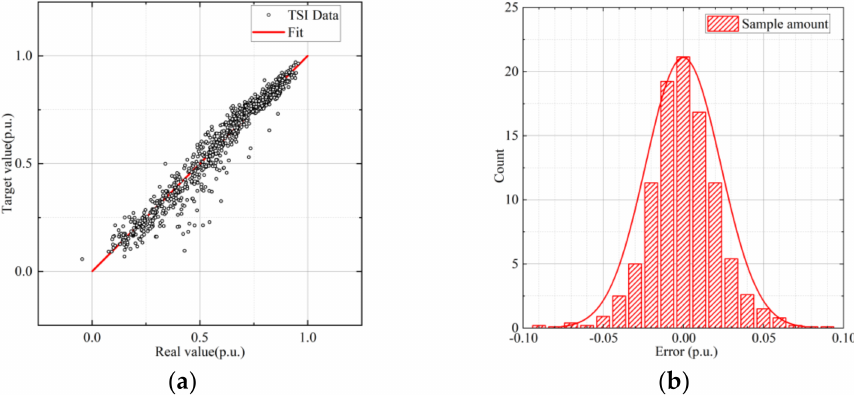
Figure 3. The visualization of testing the trained learning model: ( a ) estimate vs. true; ( b ) error distribution.